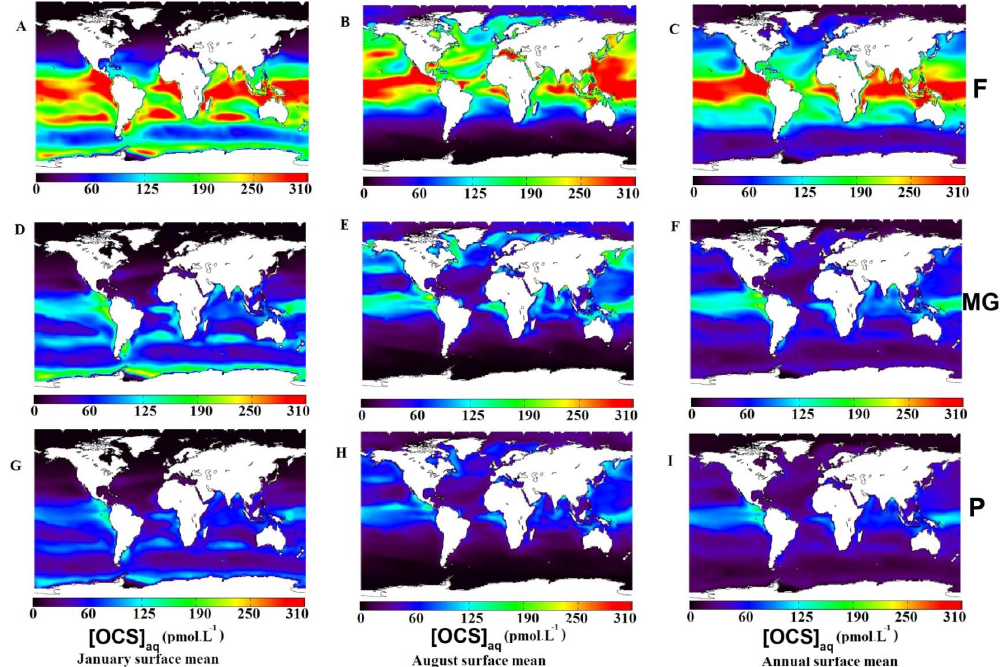
Figure 10. Monthly mean surface OCS concentrations for January (left column), August (central column) and annual mean (right column) simulated with NEMO-PISCES. The three simulations differ in the relationship used to calculate a 350 from chlorophyll: MODIS Aqua- derived, proposed in this study (F, upper row), from Preiswerk and Najjar (2000) (P, central row) and Morel and Gentili (2009) (MG, lower